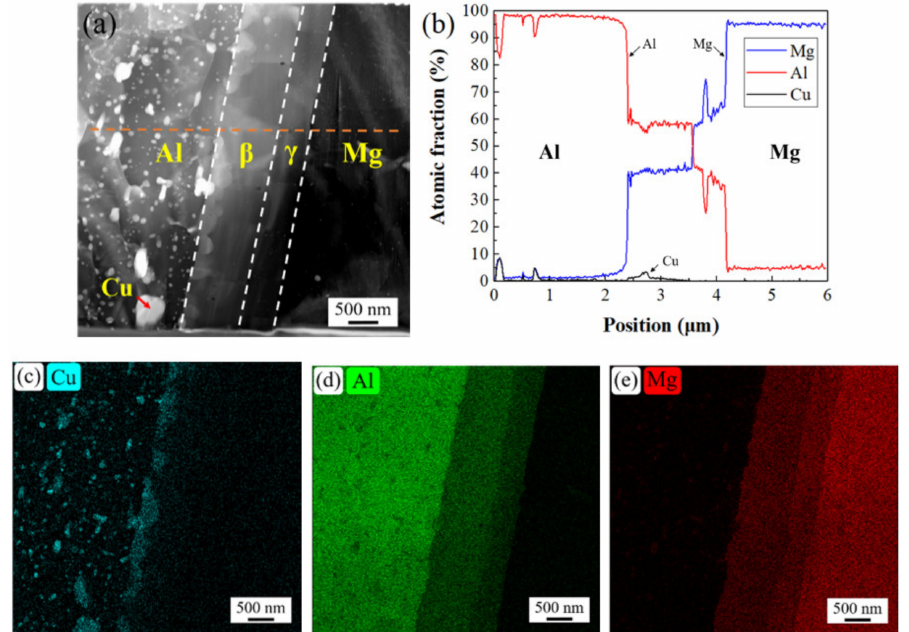
Figure 6. STEM image at location BOT ( a ), line scan results ( b ), element distribution of Cu ( c ), Al ( d ), and Mg ( e